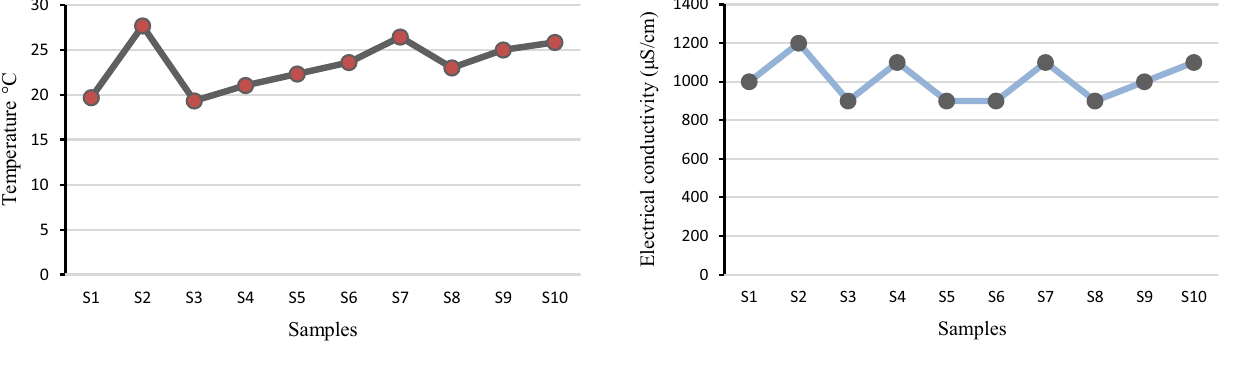
Fig. 2 Average temperature values of analyzed dairy effluents